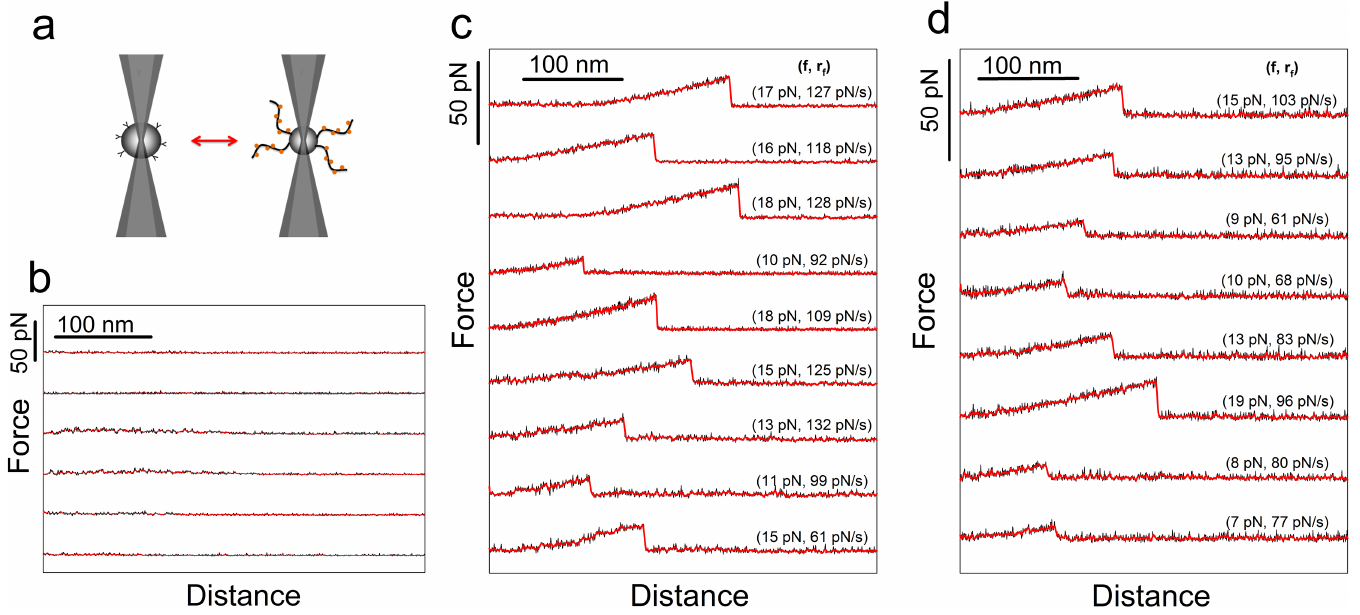
Fig 1. (a) Schematic illustration of two optically trapped beads functionalized with MUC1 and MGL respectively.During one approach–retract cycle, the beadsare brought in contact and then apart. If an intermolecular bond is formed between a MUC1 moleculeand an MGL, a force will be appliedto this bond duringbeadretraction, and ultimatelylead to its rupture. b-d: Examplesof typical curves obtainedwhen repeatingthe approach–retract cycle explained in (a) for experimental series of (b) MUC1(ST)–MGL, (c) MUC1(Tn)–MGL and (d) MUC1(STn)–MGL, respectively.Raw (black) and smoothed(red) data are shown. The smoothedcurves were used in the further data analysis. For each observedrupture event, the loadingrate r f was determinedbasedon the slope of the force curve prior to bond rupture, while the height of the jump reflects the magnitudeof the unbindingforce f .